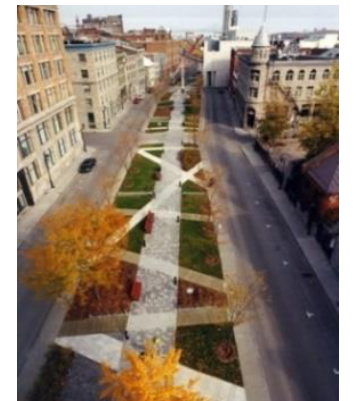
Fig. 12. The variety of materials used in creating the corridors to achieve narration in space.